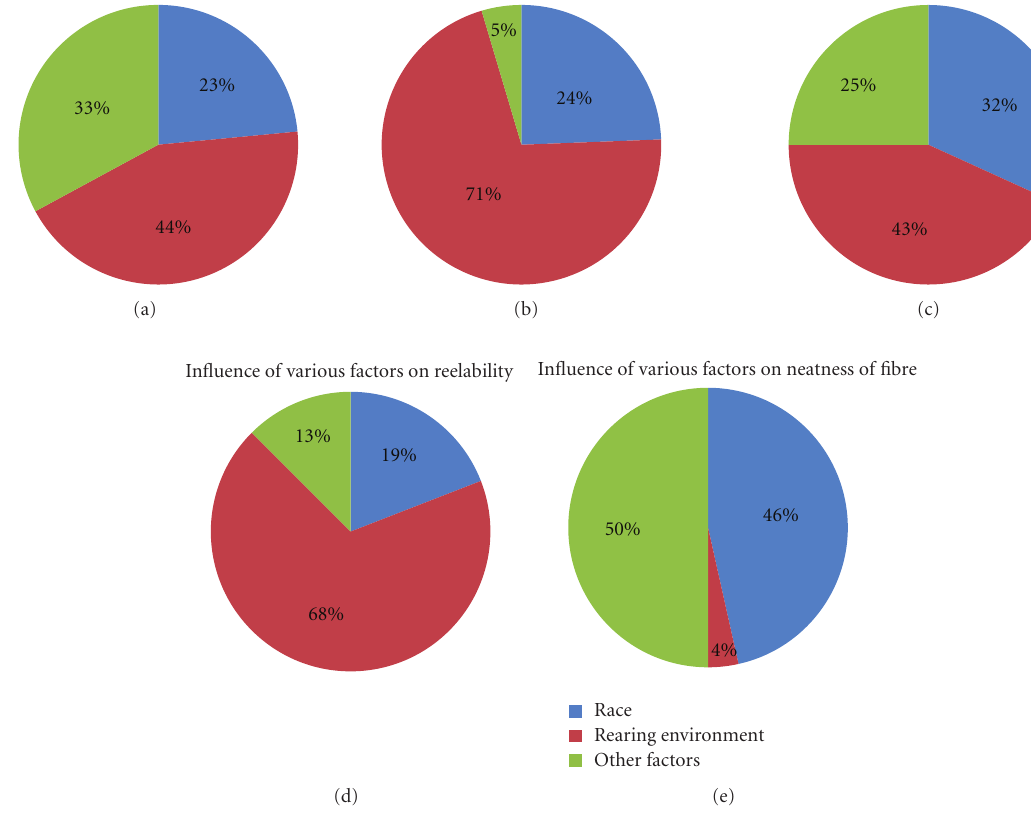
Figure 1: Influence of various factors on cocoon yield, weight, shell weight, reelability, and neatness source: [44].